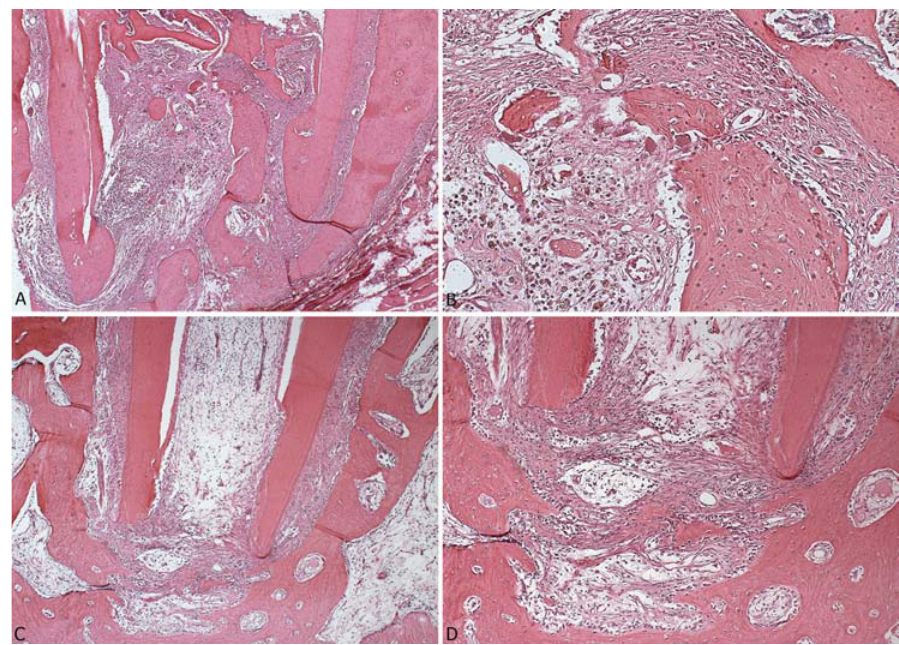
Figure 1- Representative photomicrographs of the ANP group, 90 days after the endodontic treatment, in conventional light microscopy: (A) Panoramic view of the periapical and apical regions showing intense invagination of the connective tissue into the root canal (HE, Zeiss, 5X). (B) Detail of panel A: part of the invaginated tissue after the mineralization (HE, Zeiss, 20X). (C) Panoramic view of the periapical and apical regions showing that the periodontal ligament was slightly increased (HE, Zeiss, 5X). (D) Photomicrography of